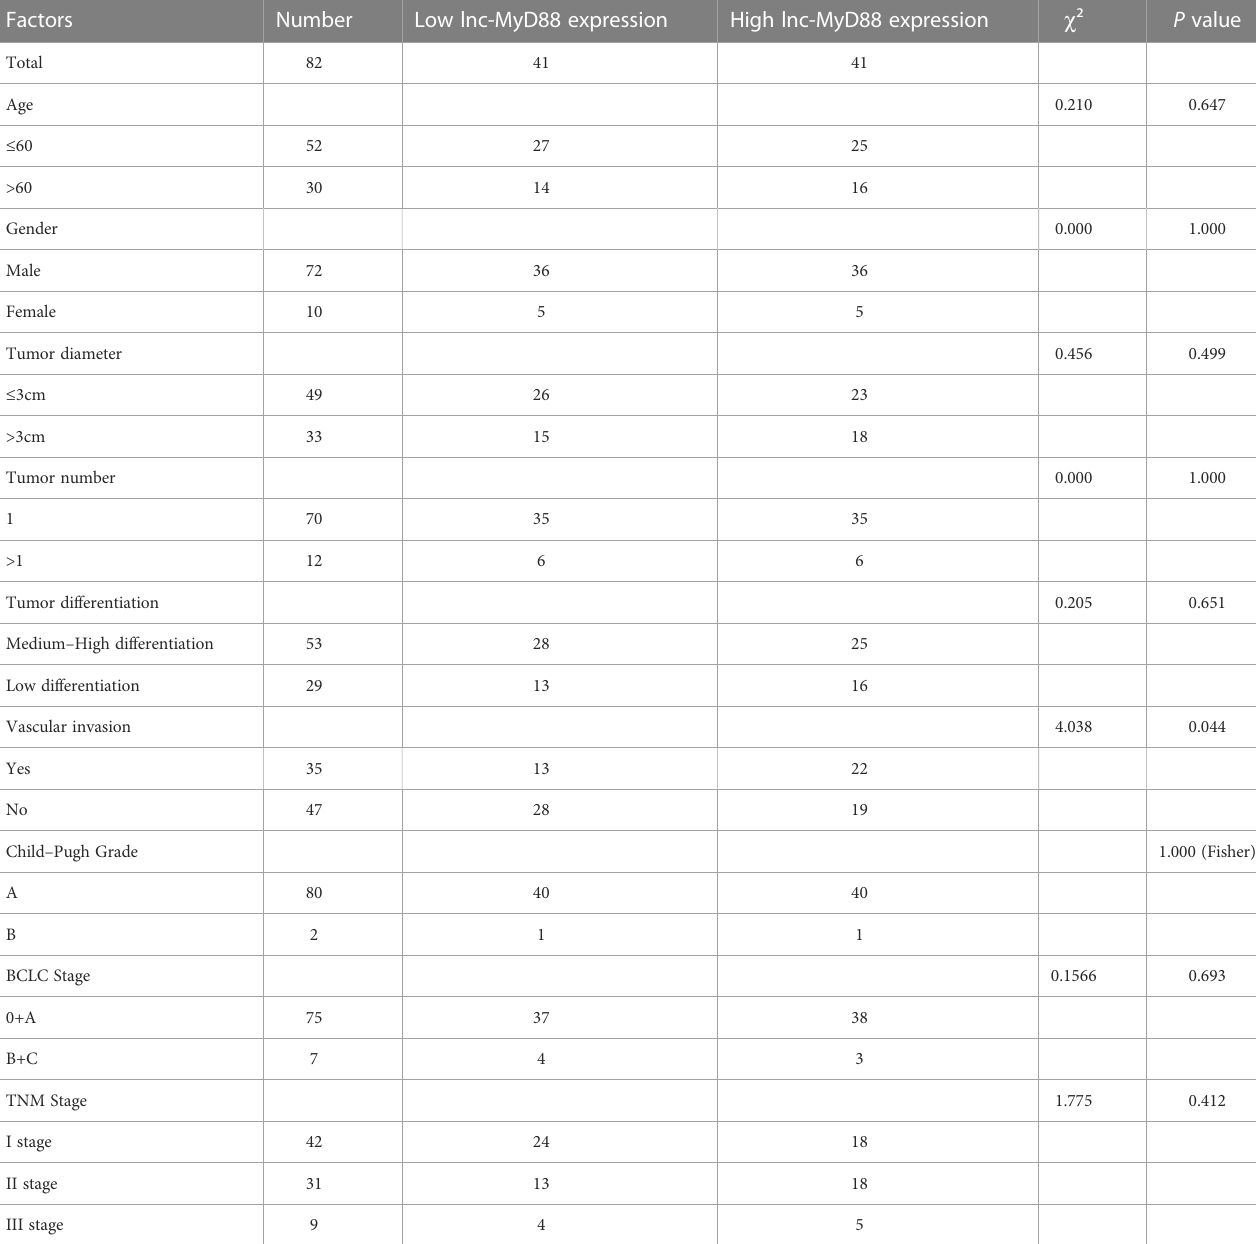
TABLE 9 The correlation of lnc-MyD88 expression and various clinicopathological characteristics in HBV-related HCC.